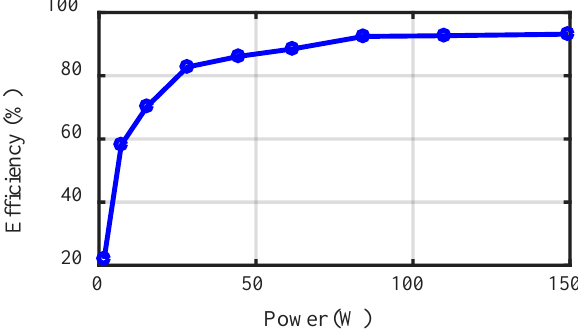
Figure 13. ( a ) Experimental result of GaN class-D amplifier with FFDISM controller output voltage v o and load current i o and ( b ) output voltage v o for reference sine wave v ref . Figure 14. The efficiency of GaN class-D amplifier at different power. Table 2. Comparative analysis of PWM and Hysteretic modulation based class-D amplifier.